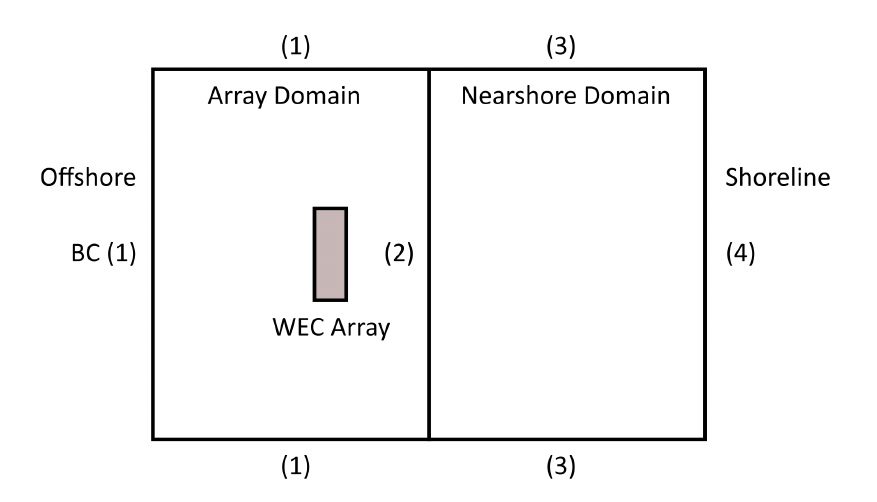
Figure 6. The computational domain used